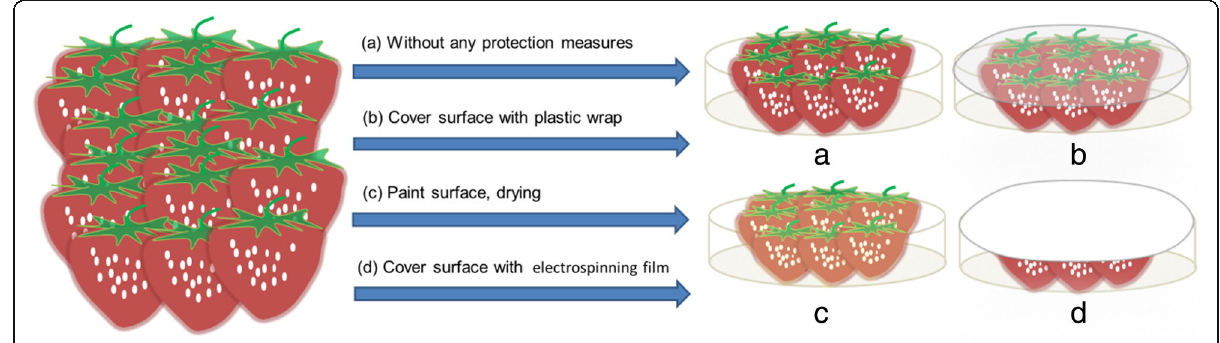
Fig. 2 The schematic diagram of strawberry preservation in every group: a blank control group in culture dish, b group in culture dish covered with plastic film, c group with CMCS/PEO solution coatings at surfaces of individual strawberries, and d group in culture dish covered with electrospun CMCS/PEO nanofiber